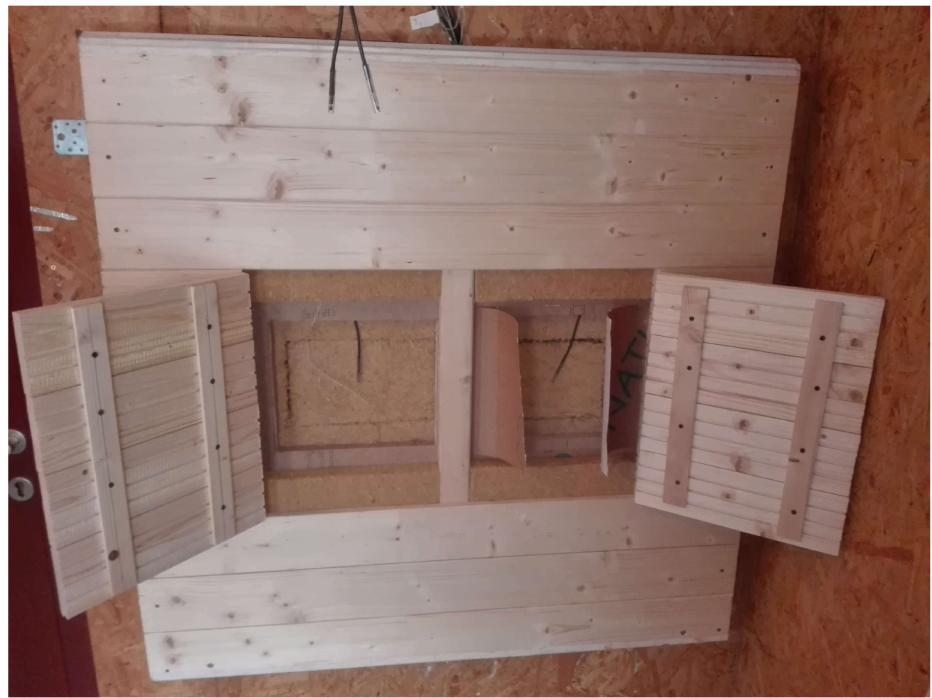
Figure 4. Log Wall LW1 and LW2 Installed in the Research Timber Structure, Interior.